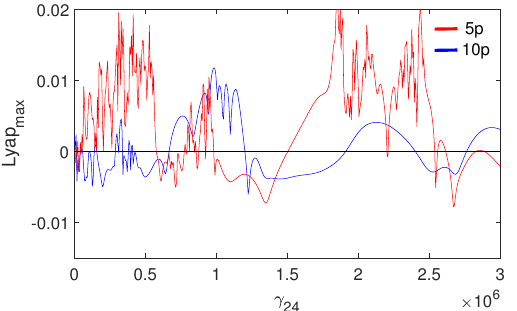
Figure 17. Maximal Lyapunov exponent for the pathological ear versus the nonlinear stiffness of the coupler ( γ 24 ).